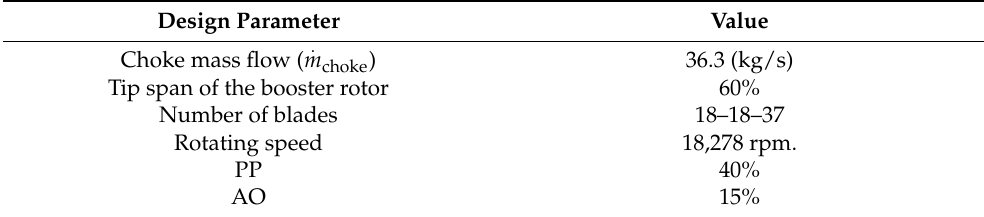
Figure 3. 3D and meridian surface diagram of the high-throughflow fan. Table 2. Key geometric and aerodynamic parameters of the high-throughflow fan.